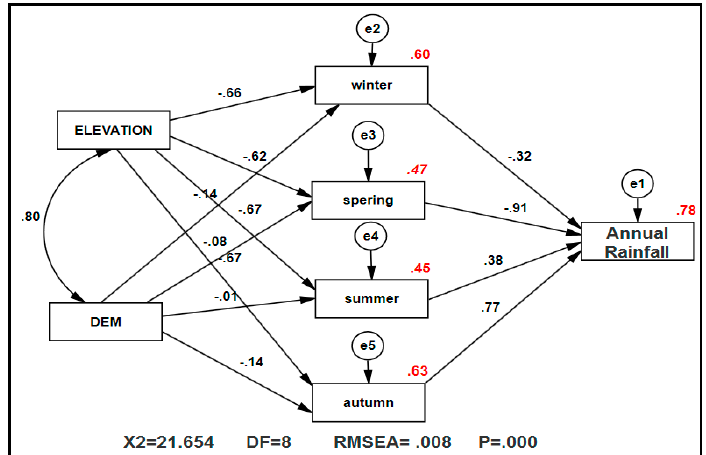
Figure 20. The effectiveness of the seasonal temperatures, elevation, and DEM on annual rainfall (eighth model). Seasonal effectiveness investigated on annual rainfall series. The effectiveness model shows that seasonal temperature series (winter, spring, summer and autumn) have direct effects on annual rainfall. Elevation and DEM have indirect effects (negative and positive effects) on annual rainfall (0.45 < R 2 < 0.60, red data).